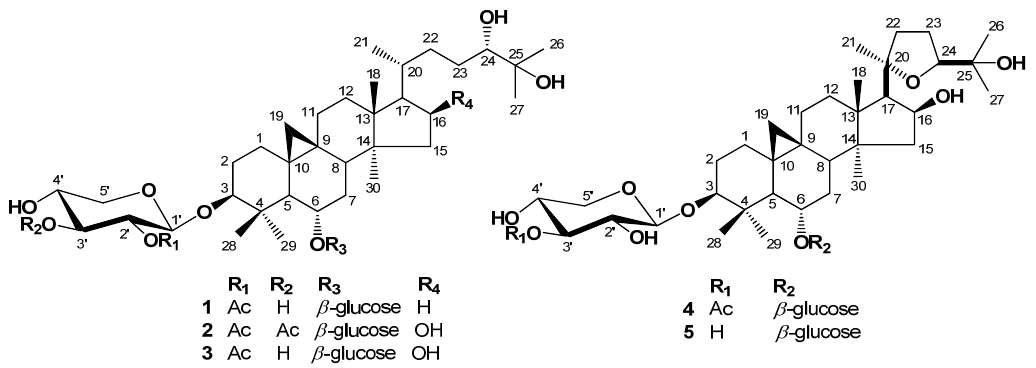
Figure 1. Chemical structures of isolated compounds 1  5